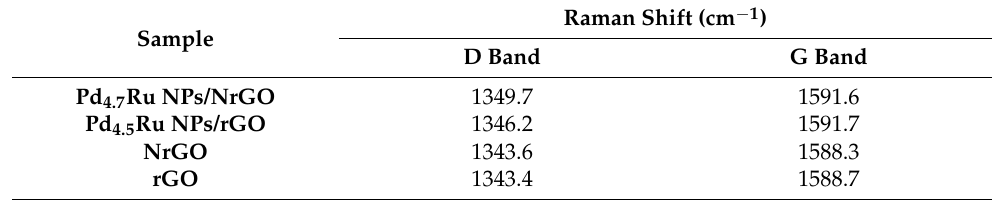
Table 1. Raman shift values of the Pd 4.7 Ru NPs/NrGO, Pd 4.5 Ru NPs/rGO, NrGO, and